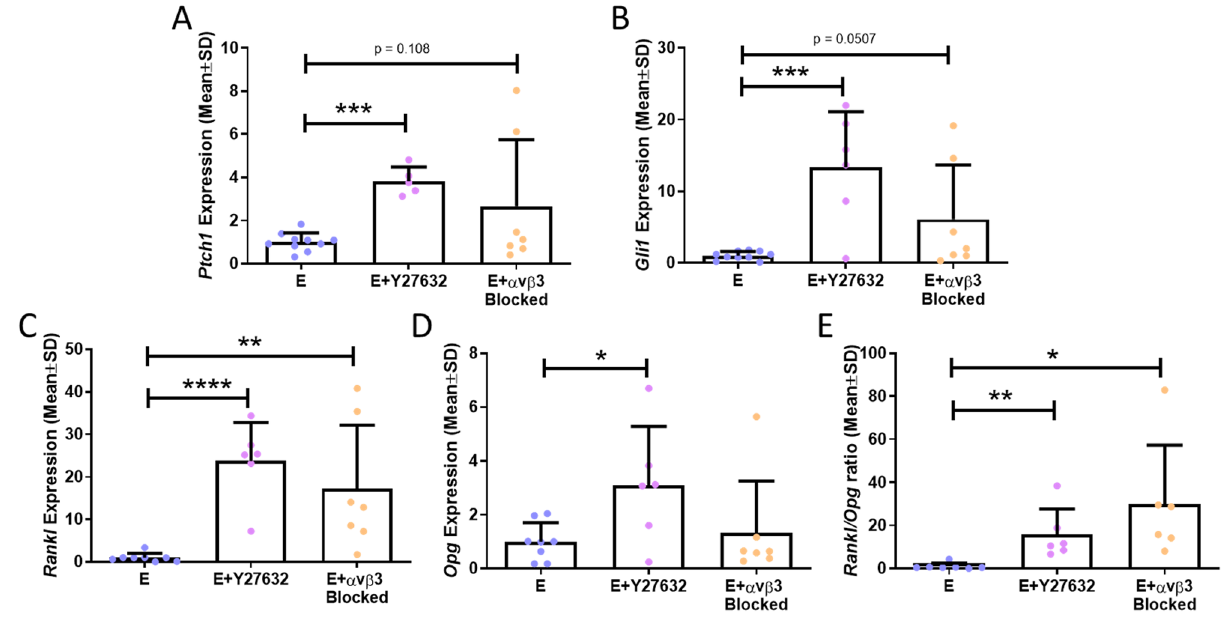
Figure 7. The effect of actin contractility inhibition (E + Y27632) and α v β 3 antagonism (E + α v β 3 antagonism) on Hh and osteoclastogenic signalling. qRT-PCR results of (A) Ptch1 expression (N = 6–10), (B) Gli1 expression (N = 6–10), (C) Rankl expression (N = 6–8), (D) Opg expression (N = 6–8), and (E) Rankl / Opg ratio (N = 6–7). (Student’s t-test, *p < 0.05, **p < 0.01, ***p < 0.001, ****p <